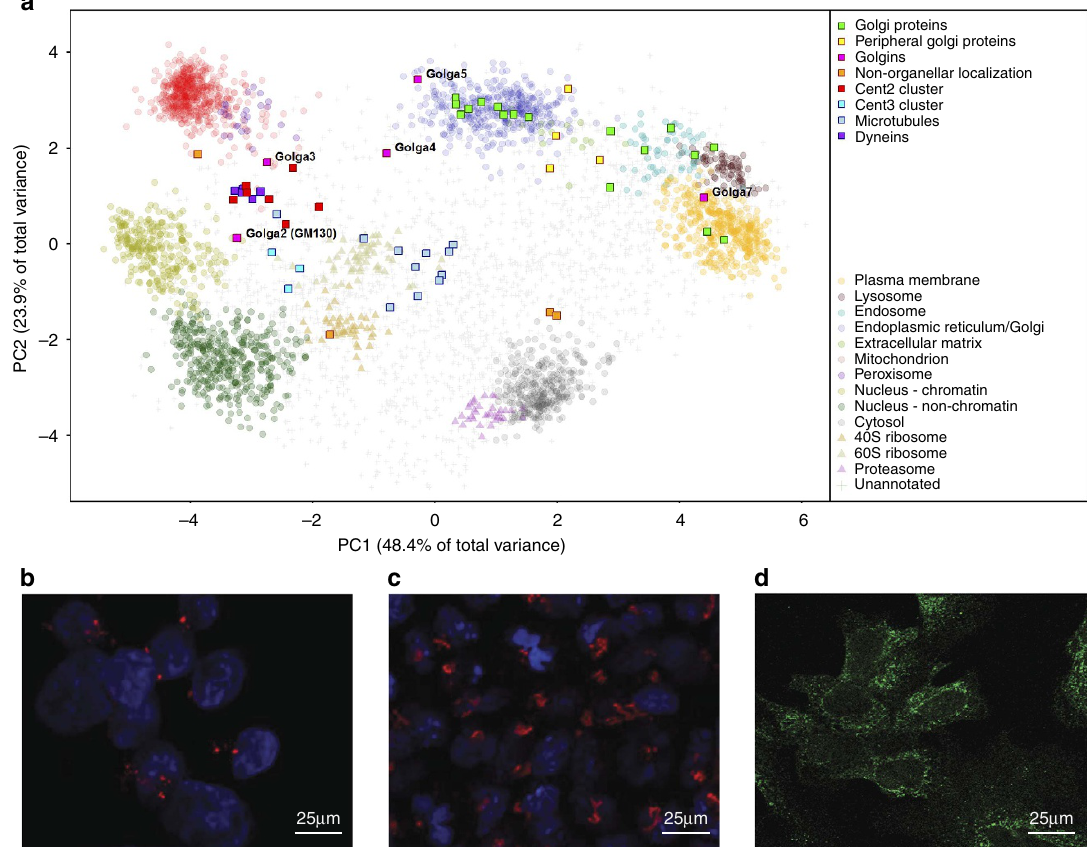
Figure 4 | Steady-state location of Golgi apparatus marker proteins. ( a ) PCA plot of data with Golgi marker proteins overlaid Golgi proteins (green) peripheral Golgi proteins (yellow), Golgins (pink), microtubular proteins (light blue), dyneins (purple), centrin 2 and associated proteins (red) centrin 3 and associated proteins (mid-blue), Golgi proteins with aberrant localization (orange). ( b ) Immunocytochemistry using anti-GM130 (red) on a self-renewing population of E14TG2a cultured in serum and LIF showing a punctate localization not consistent with the Golgi Apparatus. ( c ) Immunocytochemistry using anti-GM130 on a population of E14TG2a after 4 days in N2B27, a media promoting neural differentiation. ( d ) Immunocytochemistry on a self-renewing population of E14TG2a cultured in serum and LIF using anti-KDEL (green; ER lumenal retention signal) to verify typical endoplasmic reticular structures encapsulating the